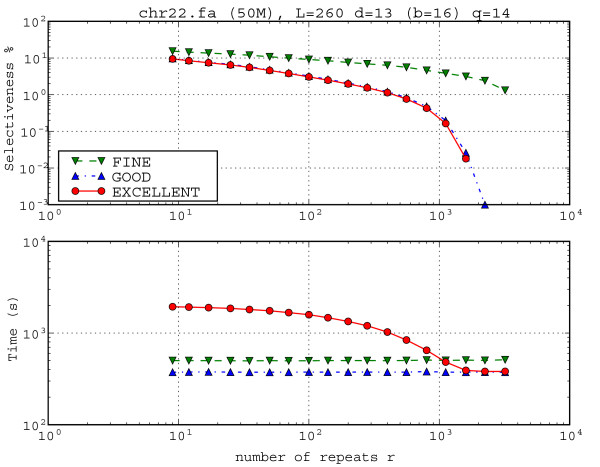
Influence of number of repeats r over selectiveness and running time. Human Chromosome 22 with parameters (L, d, r) = (260, 13, r) with q = 14. The selectiveness of 0 obtained for methods GOOD and EXCELLENT are not drawn on the log scale. As r grows, the selectiveness decreases because more frequent repeats are rarer than the less frequent ones. Also, variant FINE gets less selective as r increases. Moreover, this illustrates a case in which EXCELLENT is time consuming while not bringing an improvement on the selectiveness with respect to GOOD as we could see also in Figure 5 and Table 2.